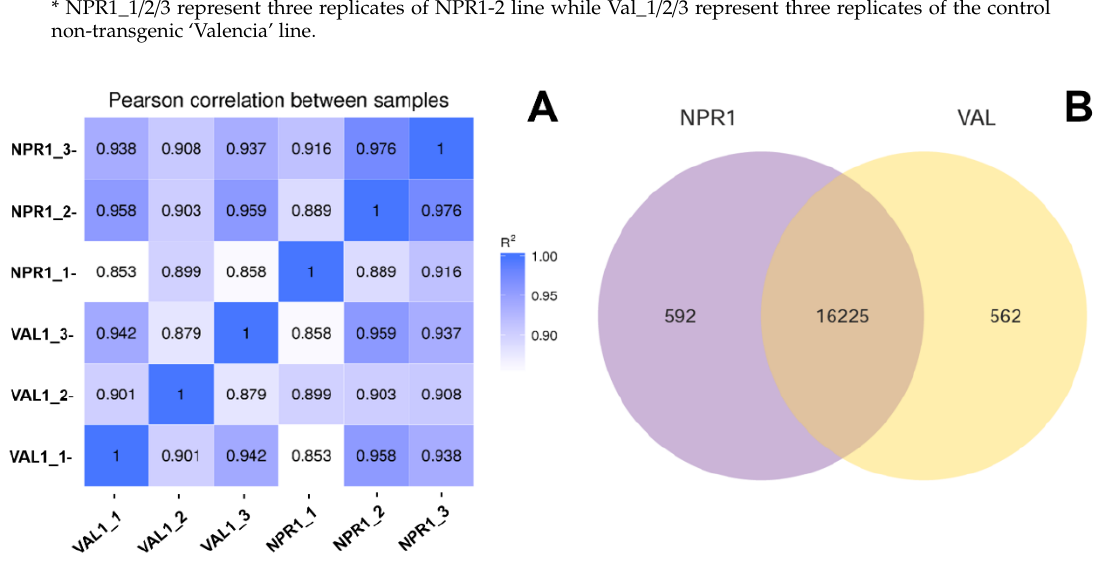
Figure 1. RNAseq analysis ( A ) Correlation between RNA-Seq samples. NPR1_1 / 2 / 3 represent three replicates of the NPR1 overexpressing line (NPR1-2), Val_1 / 2 / 3 represent three replicates of the control non-transgenic ‘Valencia’ line, heat maps of the correlation coe ffi cient between samples, R 2 means the square of the Pearson coe ffi cient; ( B ) Venn diagram of expressed genes in transgenic NPR1 overexpressing line (NPR1-2) and control non-transgenic ‘Valencia’ line. FPKM > 1 is the expression threshold, NPR1 and Val represent the AtNPR1 -transgenic line (NPR1-2) and non-transgenic ‘Valencia’ line, respectively.